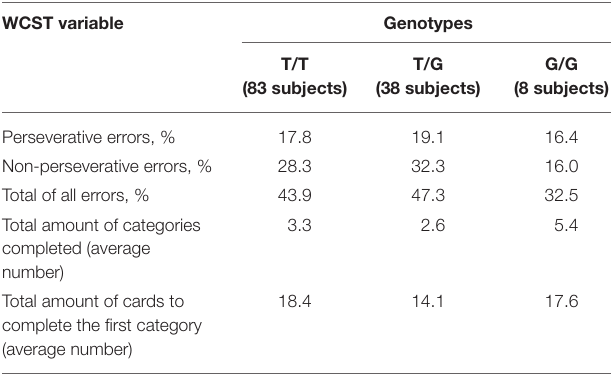
TABLE 8 | MIR137 rs1625579 polymorphism association with WCST variables in scizophrenia